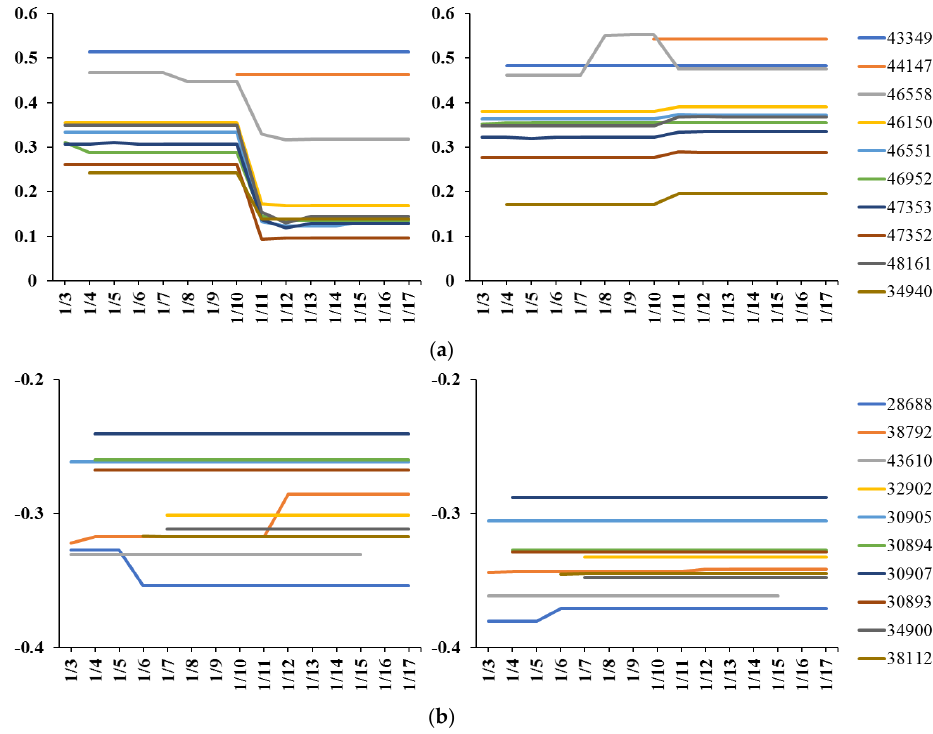
Figure 11. Averages of trend components of water area pixels before (left) and after (right) break their point, influenced by different settings of h parameter sampled in water ( a ) and land ( b ) area. Values in x -axis indicate different settings of h parameter, while values in y -axis indicate averages of trend components before or after break points. Each line drawn in the diagram indicates average of trend components in each sample pixel influenced by different settings of h parameter. They were drawn in different colors to distinguish different sample pixels. The numbers behind each line in the legend indicate the IDs of sample pixels. The no-data points in the diagrams indicate no break points were